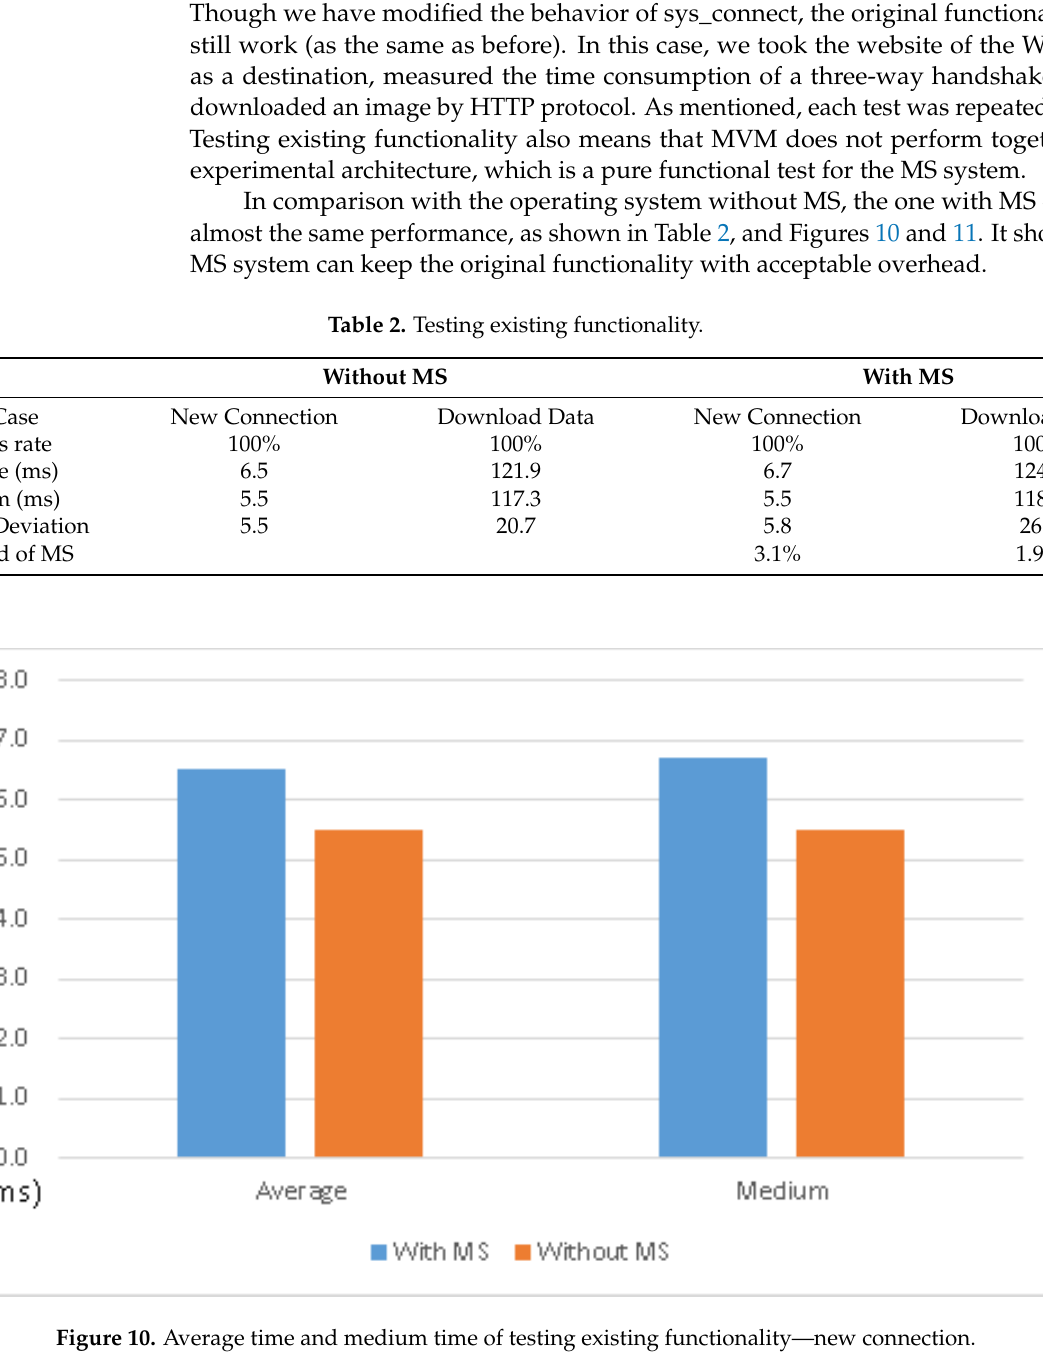
Figure 11. Average time and medium time of testing existing functionality — download data. 6.3. Connecting to Protected Server under a Normal Situation We need to consider when MS will be used in practice. In order to defend against DDoS attacks and protect a server, the MS system must work together with MVM to complete the defense procedures. This experiment focuses on the overhead of a client in the MS system under a normal situation; that is, it is combined with MVM and is not under attack. In the experiment, we assume that Proxy 1 is protected. In addition, to consider in the next experiment, we simulate a DDoS attack on Proxy 1, we deploy the whole system in an isolated local network. As a proof of concept, the IP address of Proxy 1 was hardcoded in current CCH in the test. Nonetheless, the IP address of Proxy 2 can still be changed or selected at any time. Moreover, since the HTTP functionality of the MVM system is a work in progress, we download the image by SSH in this test. As shown in Table 3, the overhead of establishing a new connection after installed MS came to almost 200%. However, as shown in Table 4, the overhead of downloading an image only came to 2.8%. We also give some figures for immediate understanding of the result, as see in Figures 12 and 13. It shows